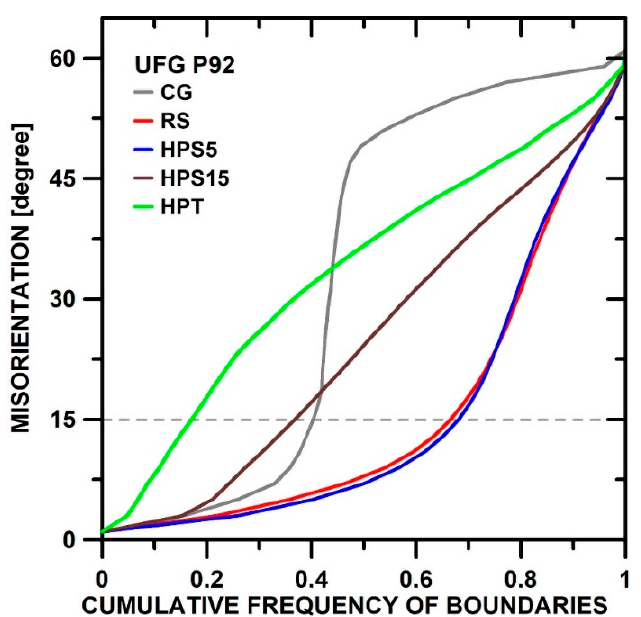
Figure 1. Grain microstructure (orientation contrast with high-angle grain boundaries (HAGB) only, normal direction (ND) and texture (poles of {110} planes) at room temperature before creep for ( a ) as-received coarse-grained (CG), ( b ) rotation swaging (RS), and ( c ) high-pressure sliding, HPS5 and ( d ) HPS15; high-pressure torsion (HPT) is similar to HPS15. Rolling directions (RD) are parallel with the pipe axis in CG state and shear direction in SPD-processed states.